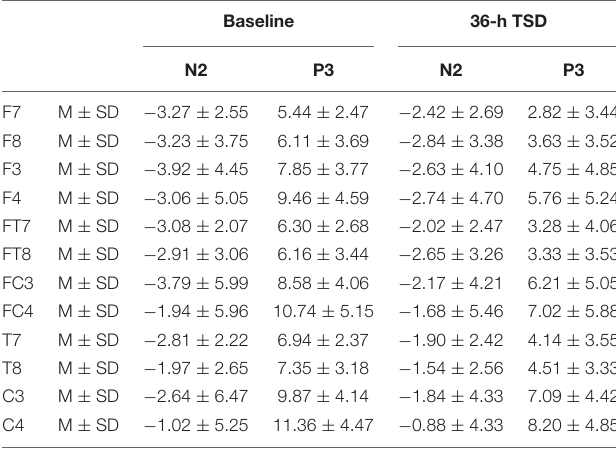
TABLE 2 | The average peak amplitude of the N2 and P3 components in the correct response condition across multiple electrode sites at baseline and after 36-h TSD.